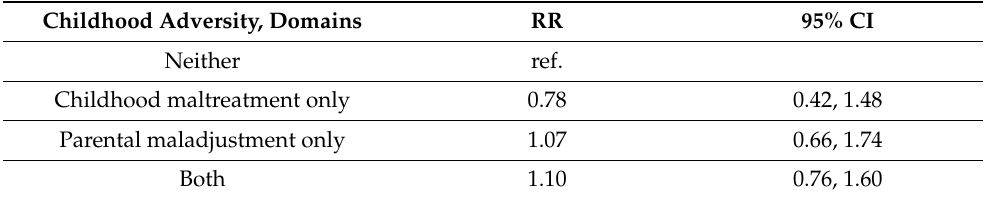
Table A3. Adjusted associations of childhood adversity domains, with early age at menarche (<12 years), relative risk ratios and 95% confidence intervals (N =